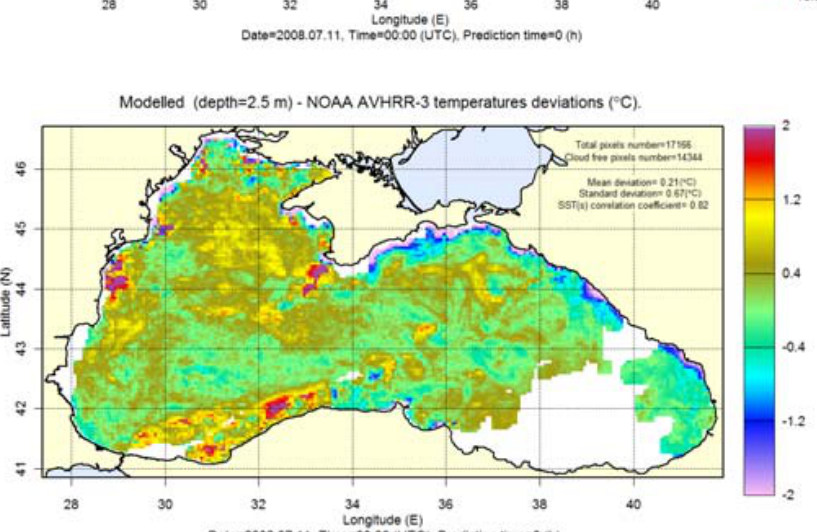
Figure 8 SST maps on 11 July 2008 retrieved from AVHRR data (upper panel), simulated by the model (central panel) and their difference (lower panel)